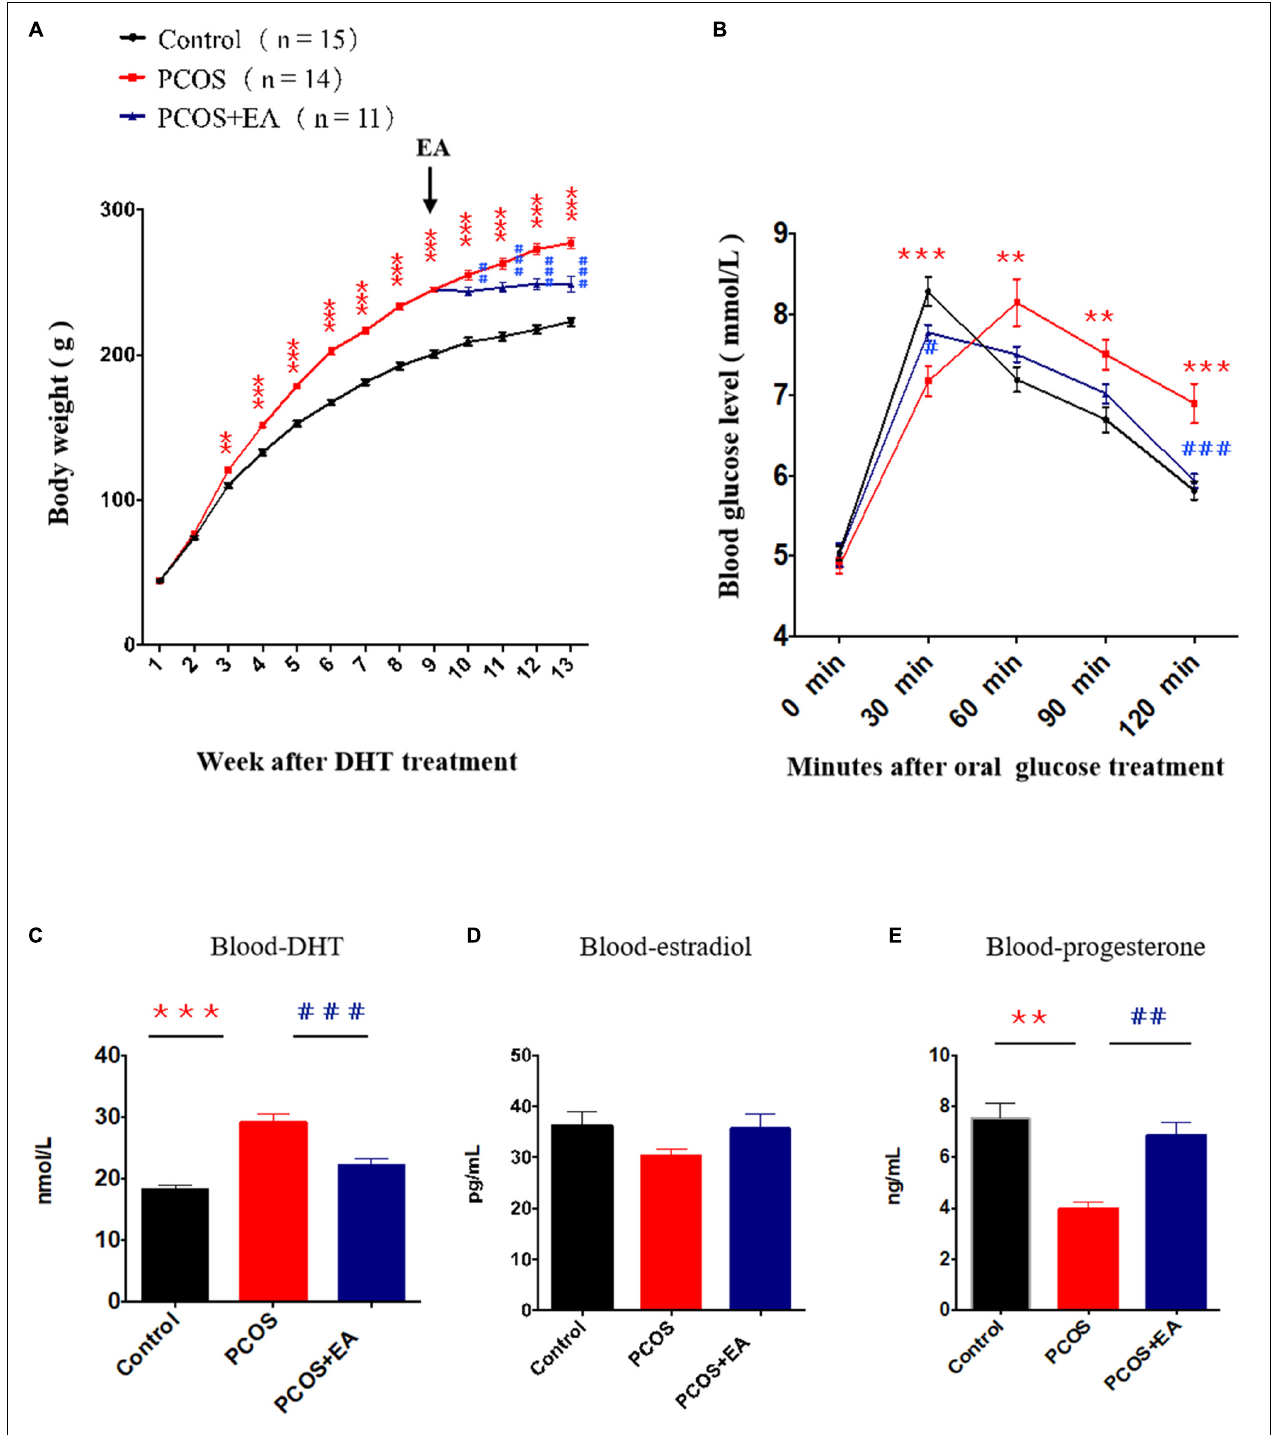
FIGURE 2 | DHT induced a PCOS-like phenotype, and the effect of EA treatment on body weight, insulin resistance and steroids. Rats at 21 days of age were implanted with DHT to induce a PCOS-like phenotype. After 8 weeks of DHT treatment, rats of PCOS + EA received EA treatments for 4 weeks. (A) Body weights of rats in each group. Arrow indicated the beginning of the EA trentment. (B) The oral glucose tolerance test at the end of the experiment. (C–E) Serum levels of DHT, estradiol, and progesterone. ** p < 0.01, *** p < 0.001 vs. Control; ## p < 0.01, ### p < 0.001 vs. PCOS.